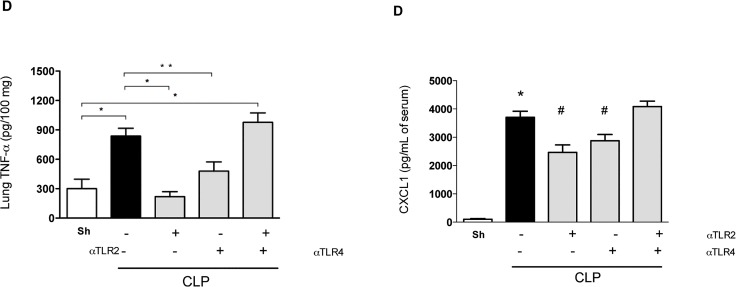
Blockade of either TLR2 or TLR4 reduces lung inflammation after polymicrobial sepsis.Mice were pre-treated with individual or combined anti-TLR2 or anti-TLR4 antibodies (45 minutes before the CLP procedure). Single treatment resulted in lower levels of TNF-α (A), IL-1β (B), CXCL1 (C) and myeloperoxidase in the lung 6 hours after sepsis compared to the negative control isotype IgG antibody treatment (black bar). The combined treatment with both anti-TLR2 and anti-TLR4 showed moderate improvement when compared to the control treatment-group. * p<0.05 between the CLP and Sham groups. # p<0.05 between the antibody treatment groups and negative control isotype IgG treated-group. Antibody dose (1 mg/animal). Used 6 animals/group, except isotype IgG antibody treated group (n = 10).